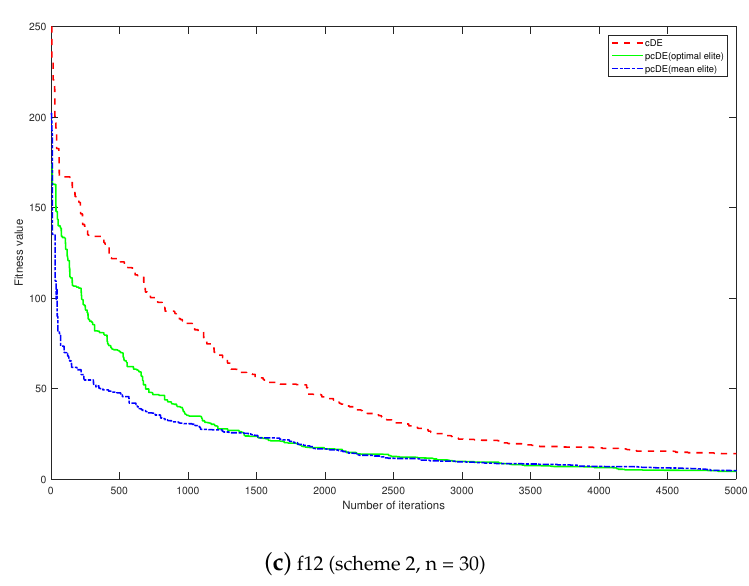
Figure 4. Performance trends of pcDE and cDE algorithms under three different